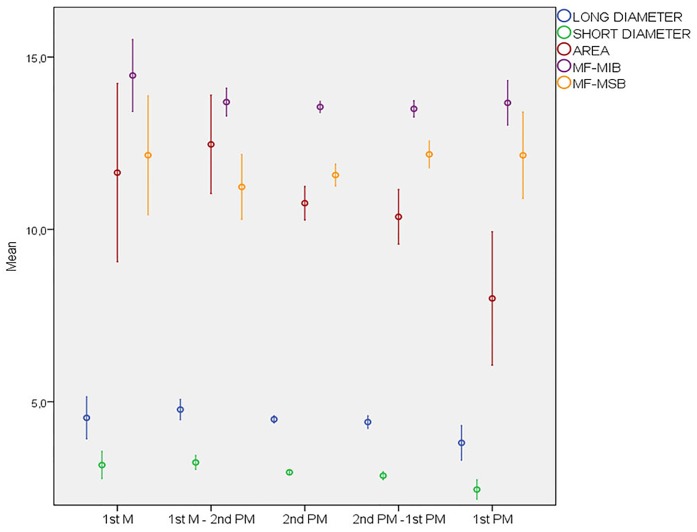
MF morphometric characteristics with respect to anteroposterior position.MFs presented a statistically significant reduction in dimensions (long diameter, short diameter, and area) as their position moved closer to the midline. The area and long diameter of the MFs located below the 2nd premolar and those located between 1st molar and 2nd premolar were significantly higher compared to the MFs located below 1st premolar. The short diameter of the MFs located below the 1st molar, between 1st molar and 2nd premolar, and below the 2nd premolar was significantly higher compared to the MFs located below the 1st premolar. In addition, the short diameter of the MFs located between the 1st molar and 2nd premolar was significantly higher compared to the MFs located between the 2nd premolar and 1st premolar.